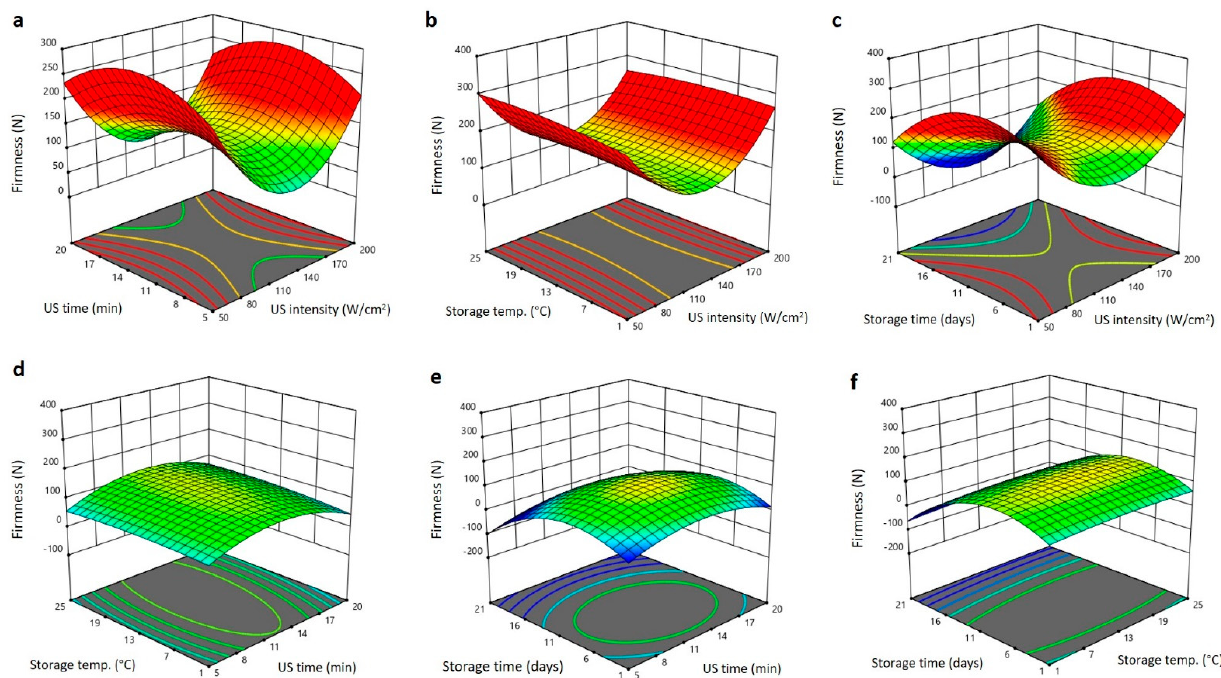
Figure 3. Response surface plots of firmness of Barhi dates as a function of US time and US intensity ( a ), storage temperature and US intensity ( b ), storage time and US intensity ( c ), storage temperature and US time ( d ), storage time and US time ( e ), and storage time and storage temperature ( f ).